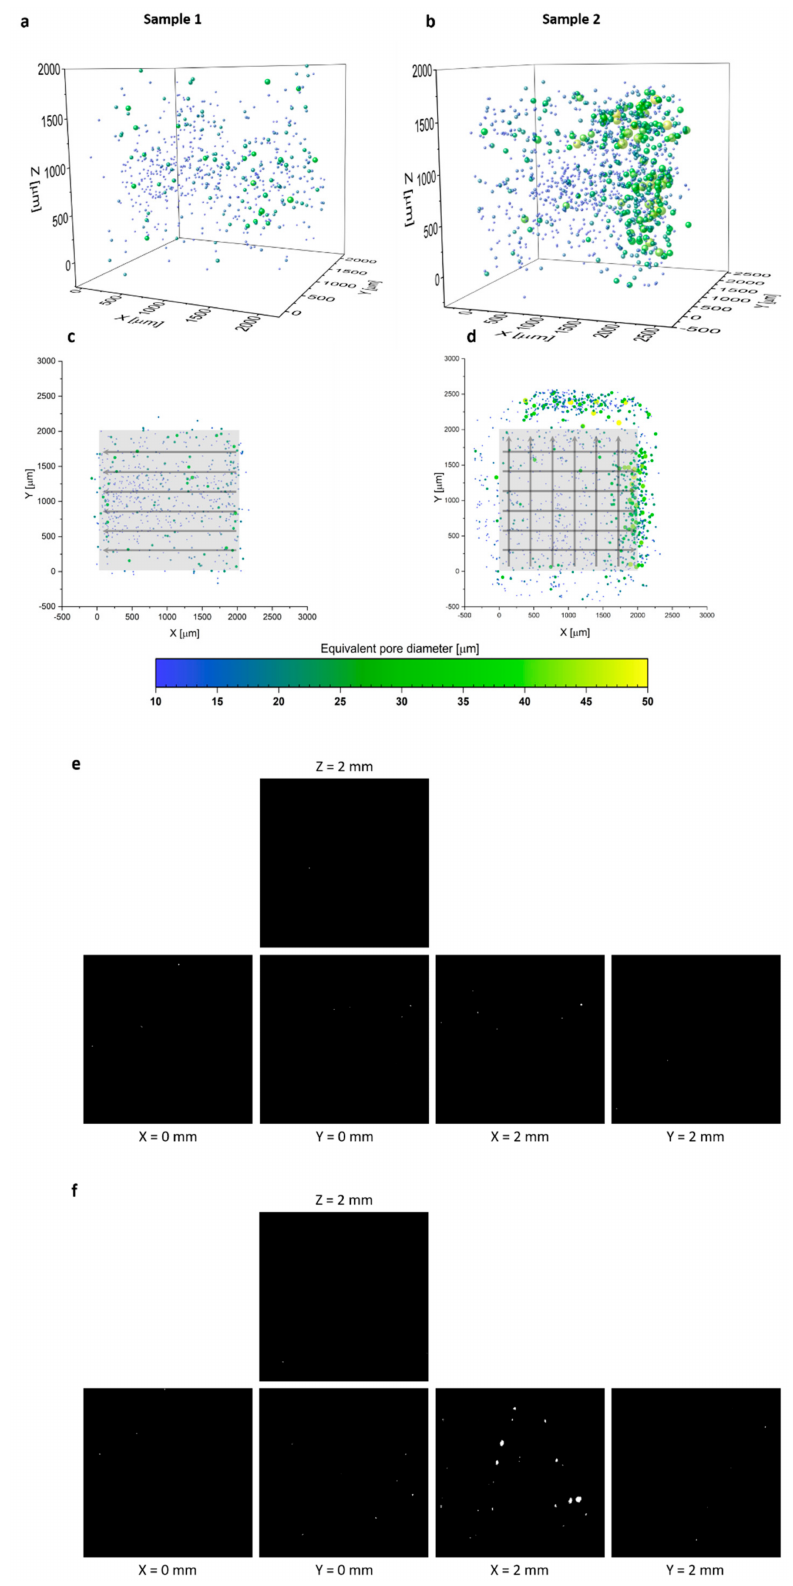
Figure 3. 3D ( a , b ) and X-Y ( c , d ) plane projections of visualized pores (10–50 micrometers) with illustrated laser scanning strategies. Most of the pores are located at the end of the laser tracks, where laser off events occur. Panels ( e , f ) represent the distribution of the pores at the surfaces of the target shape-printed Samples 1 and 2, respectively (The pores are in